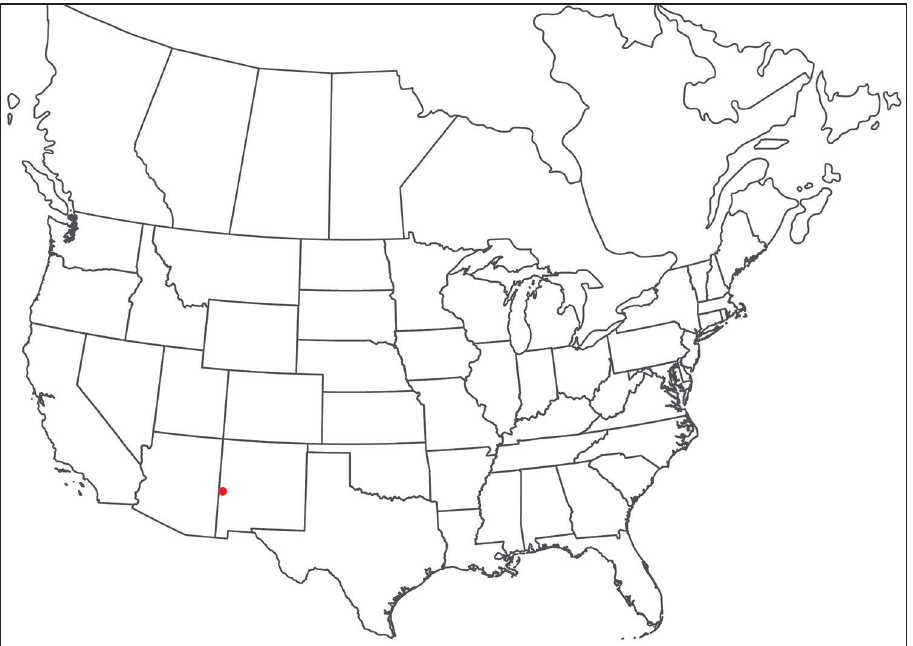
Figure 59. Torrenticola dolichodactyla sp. n.